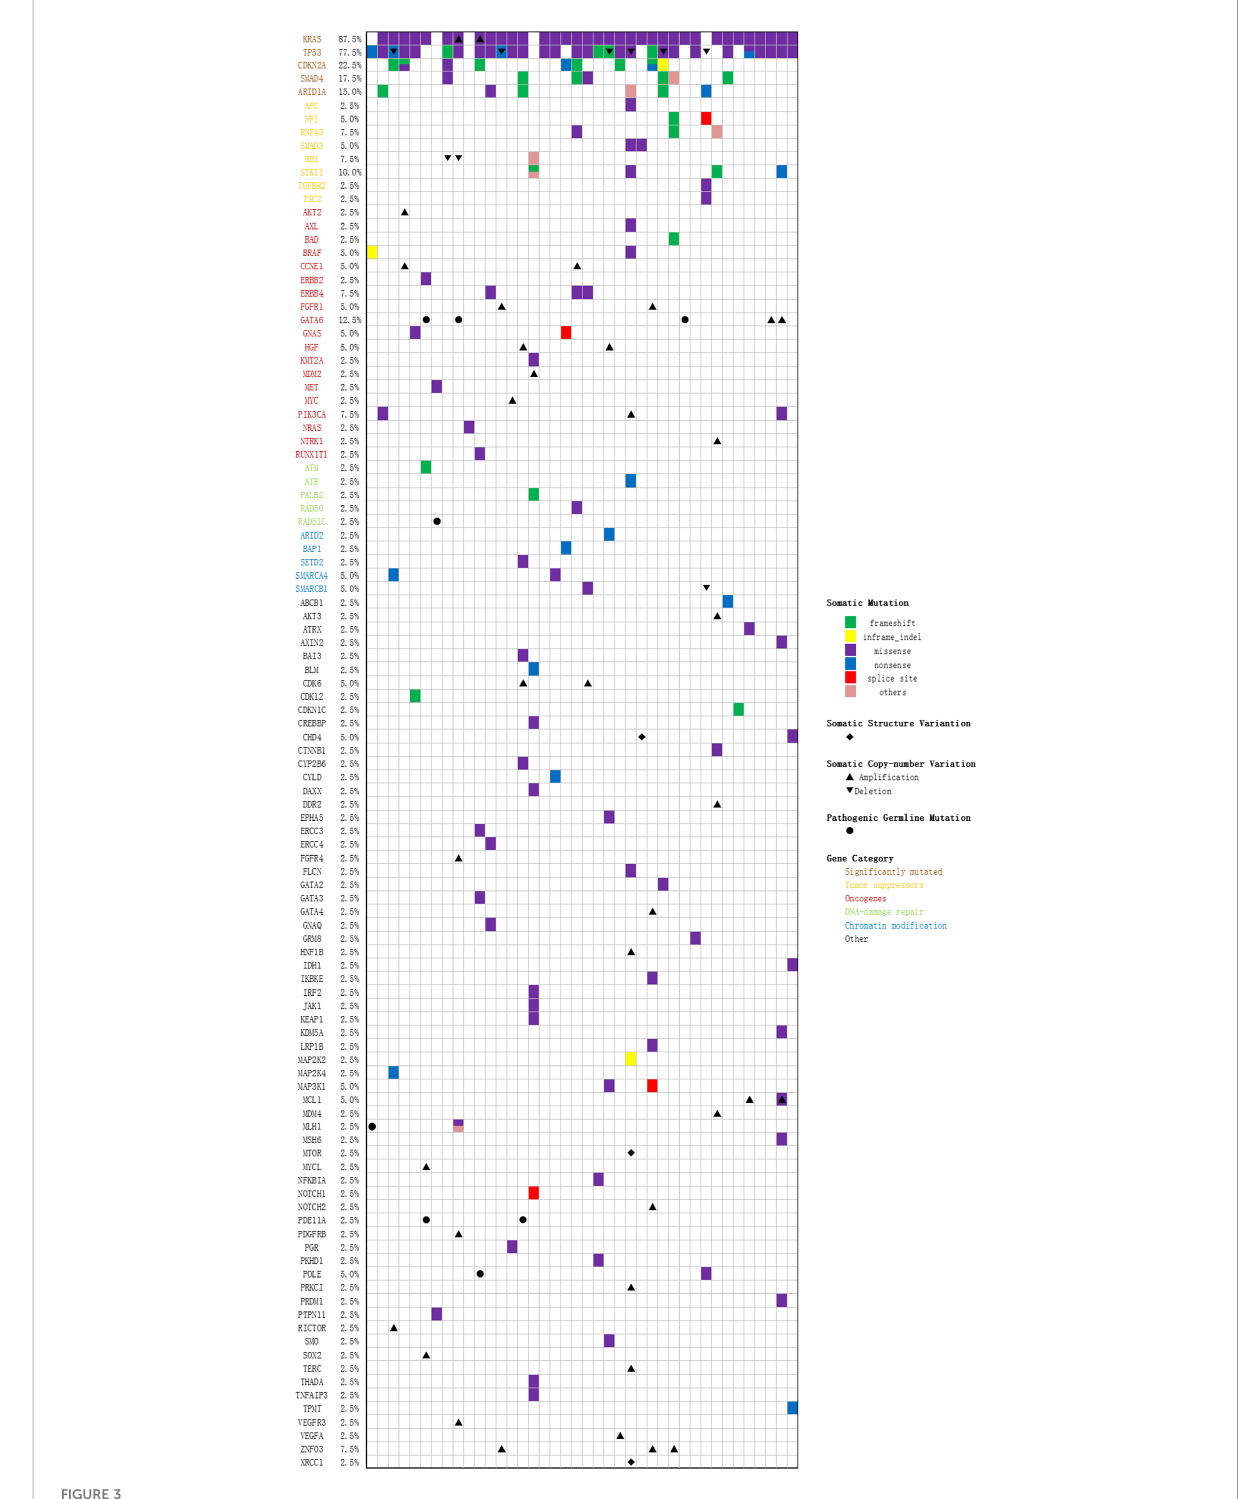
FIGURE 3 Oncoprint of 425 genes in 40 PAC